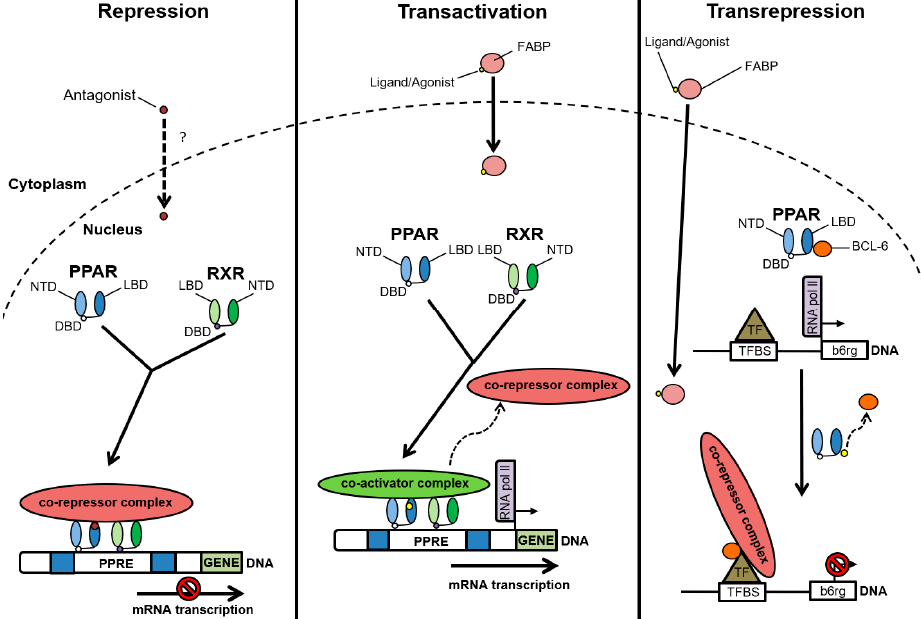
Figure 3. Regulatory mechanisms of gene transcription by peroxisome proliferator-activated receptors (PPARs). Each PPAR structurally comprises an N-terminal domain (NTD), a DNA-binding domain (DBD), and a ligand-binding domain (LBD). In the absence of a ligand or in the presence of an antagonist, the PPAR-RXR heterodimer associates with nuclear receptor co-repressor proteins, leading to repression of PPAR target genes (Repression). Fatty acid-binding protein (FABP) associates with the ligand/agonist to transport it into the cell. Upon ligand binding, a conformational change in PPAR leads to co-repressor dissociation, and co-activators are recruited. The activated PPAR-RXR heterodimer binds the peroxisome proliferator response element (PPRE) and stimulates target gene transcription (Transactivation). In macrophages, endothelial cells, and vascular smooth muscles, in the absence of a PPAR β / δ agonist or ligand, the receptor will scavenge BCL-6 (a PPAR β / δ -associated transcriptional repressor). Once PPAR β / δ neutralizes BCL-6, transcription factors (TFs) bind to TF-binding sites (TFBSs), allows transcription of the genes repressed by BCL-6. However, the binding of a PPAR β / δ ligand to PPAR β / δ will result in BCL-6 dissociation, leading to co-repressor-dependent transrepression of BCL-6 targeted genes, such as b6rg , which encodes a sequence-specific transcription repressor (Transrepression). The dashed arrow with a question mark indicates that it is not known how the antagonist is translocated to the cell nucleus. The curvy arrow indicates the dissociation of the co-repressor from the transcription factor.